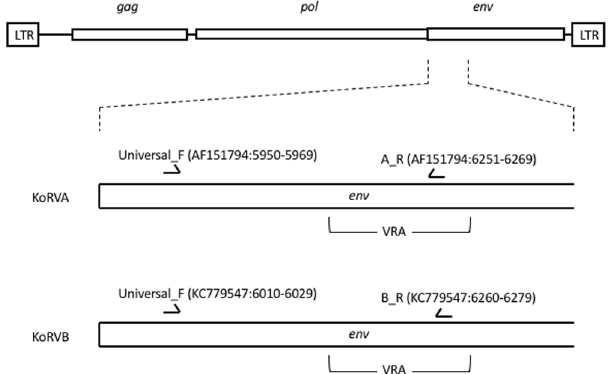
Figure 6. Location of PCR primers used to amplify koala retrovirus KoRV env region from the blood of free-living koalas ( Phascolarctos cinereus ). Primer coordinates are with respect to genome sequences which are representative of KoRV subgroup A (Genbank accession AF151794) and subgroup B (Genbank accession KC779547). Primer sequences are in Table S1. VRA: variable region A; LTR: long terminal